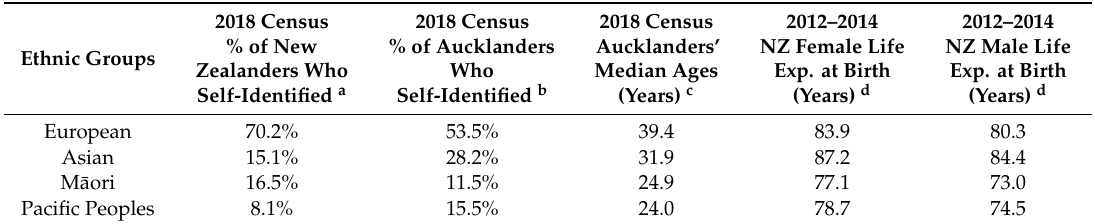
Table 1. Comparative ethnic profiles in New Zealand and T¯amaki Makaurau Auckland showing ethnic groups’ median ages for Auckland residents and population level life expectancy at